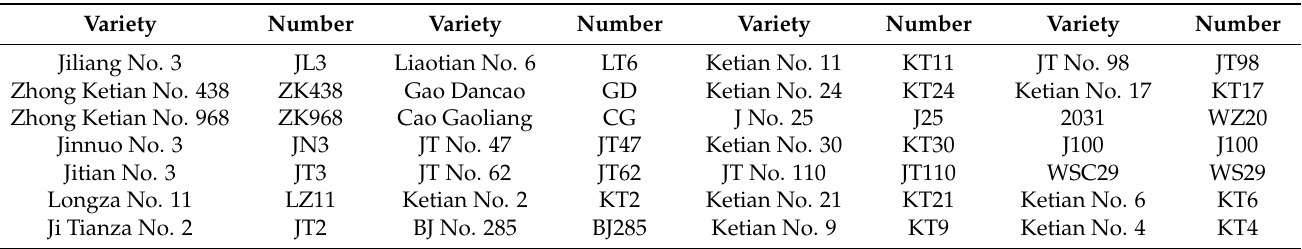
Table 1. Number of sweet sorghum